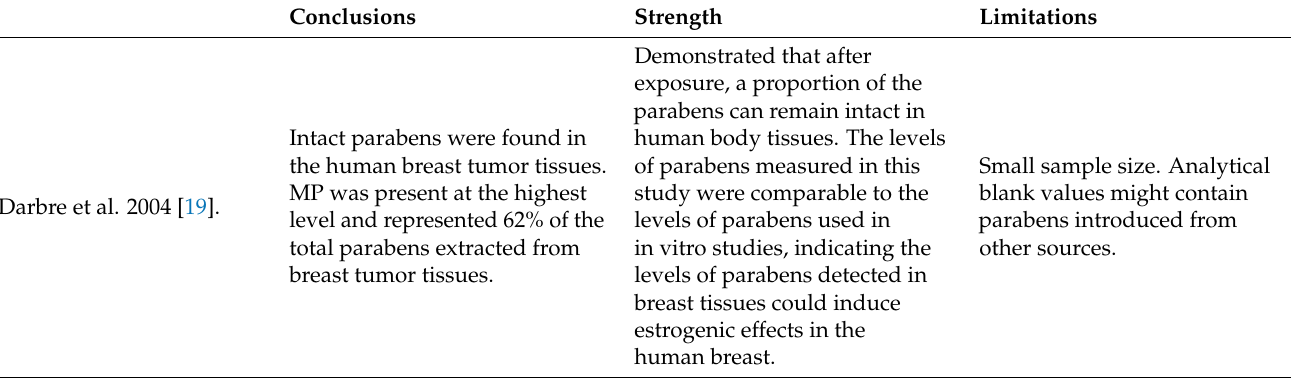
Table 1. Summary of Human Studies on Paraben Exposure and Breast